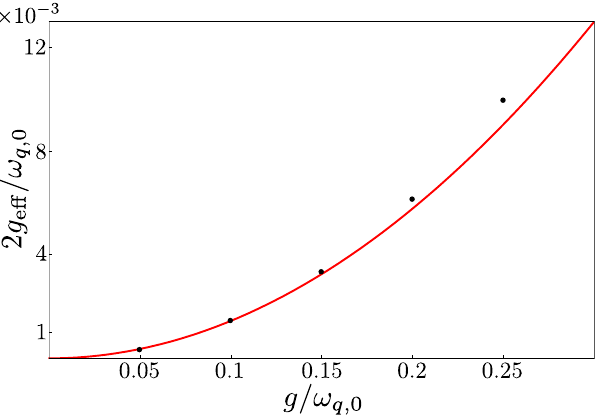
Figure 4. Comparison of analytical (red curve) and numerical (black dots) results for the effective coupling between the states |1, 0, g 〉 and |0, 1, e 〉 . The graph shows the minimum energy splitting 2 g eff / ω q ,0 as a function of g / ω q ,0 , where g = g a = g b , using the same parameters as in Fig.